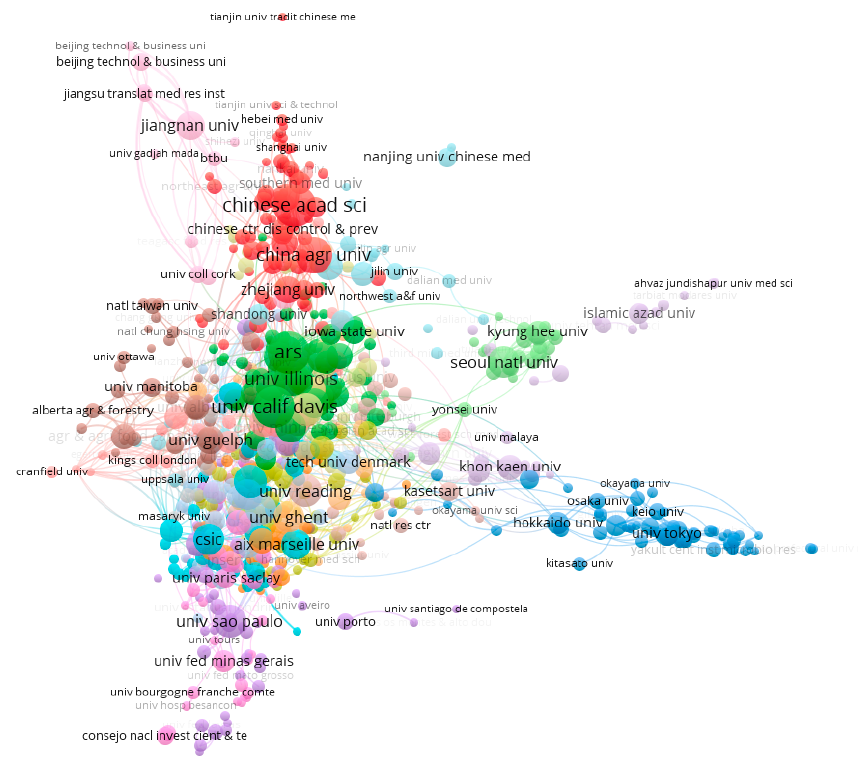
Figure 13. Network visualization map showing organizations’ contributions.